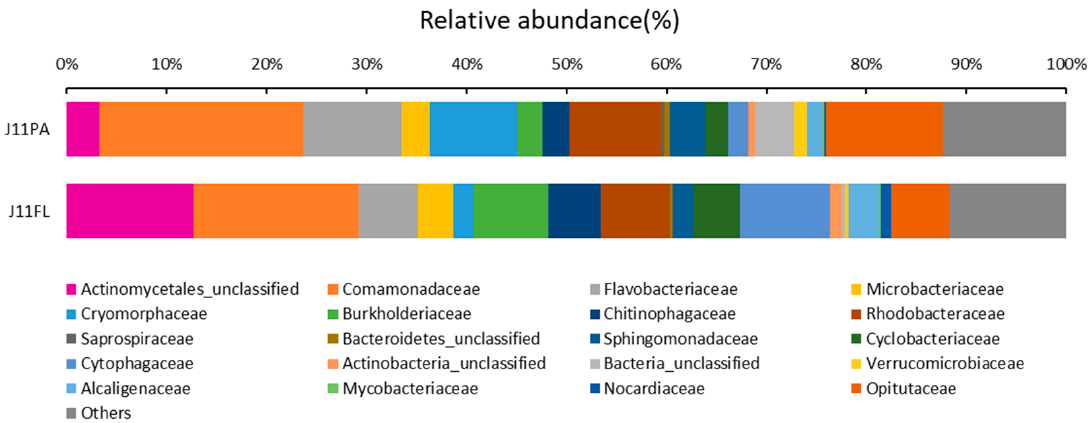
Figure 5. Structural analysis of the bacterial community at the family level at point J11. PA: particle- attached bacteria, FL: free-living bacteria.